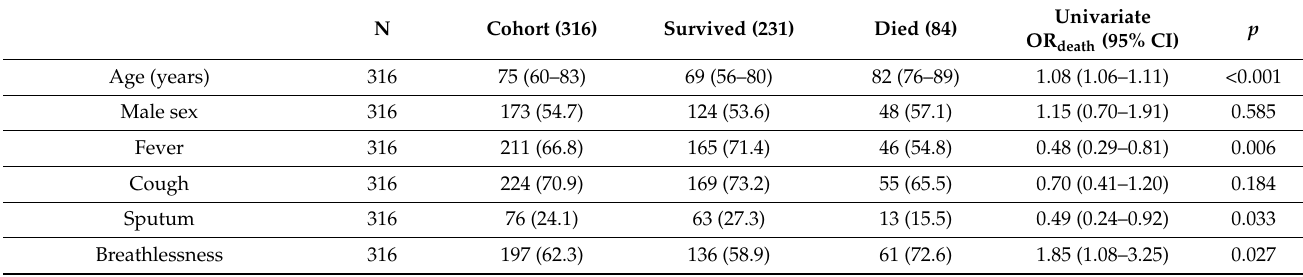
Table 1. Baseline cohort characteristics including univariate logistic regression analyses and associated p values. Odds ratios are stated per 1 unit increase in the independent variable unless otherwise